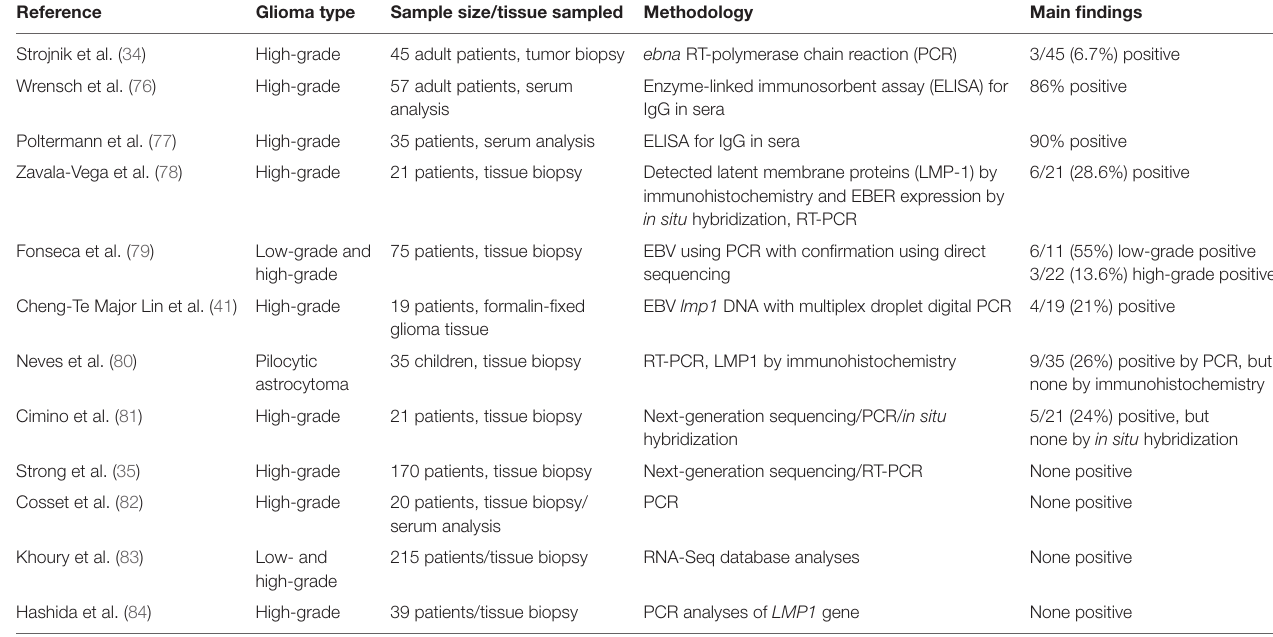
TABLe 1 | Selected examples of studies investigating Epstein–Barr virus (EBV) in